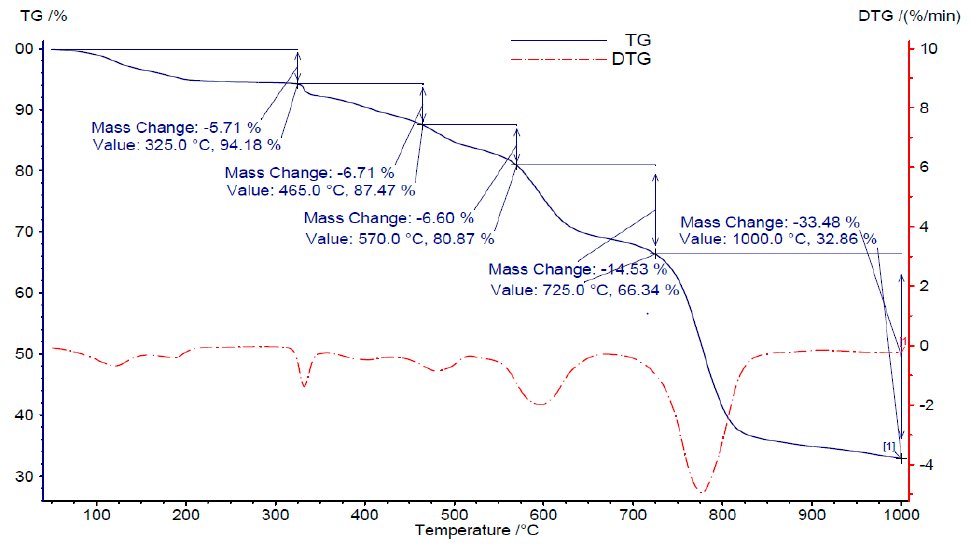
Figure 12. TG and DTG curves of AB 113 dye.